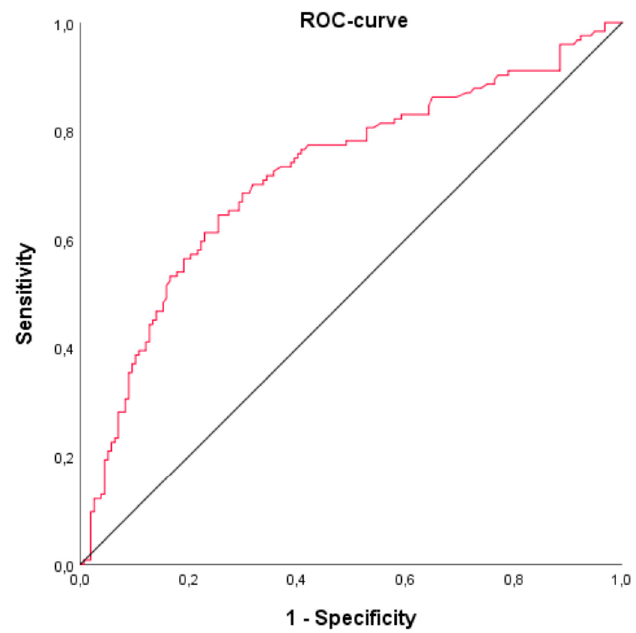
Figure 1. Receiver operating characteristic curve (ROC) and area under the curve (AUC) for bilirubin on day 5 of ECLS therapy as a discriminator for mortality ( n = 298). AUC = 0.72 (95% confidence interval (CI): 0.66–0.78).